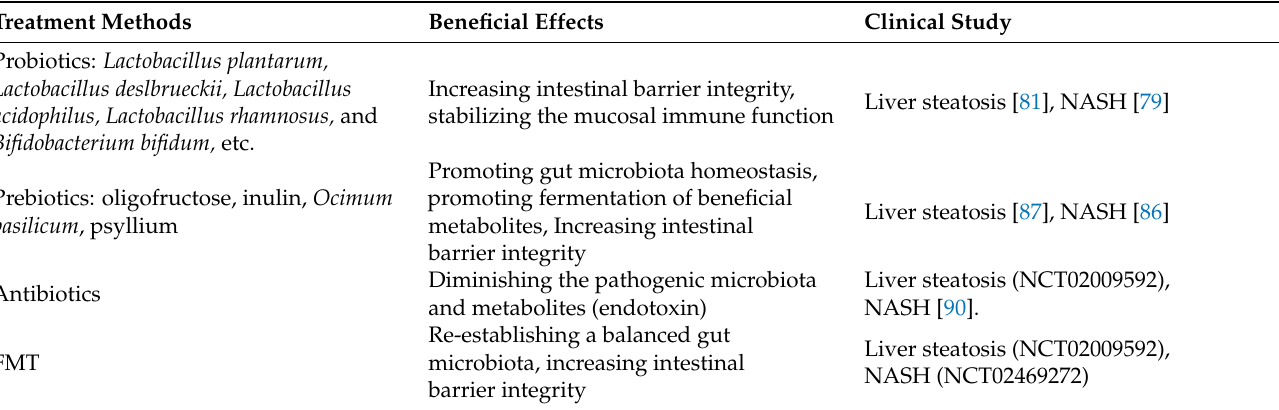
Table 1. Microbiota-based treatment targeting gut–liver barrier for